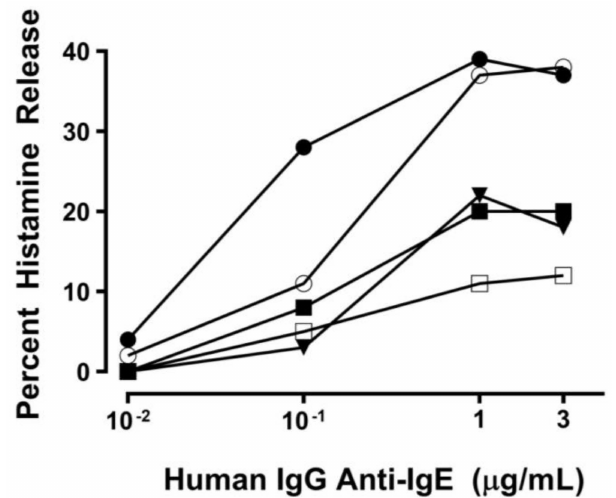
Figure 1. E ff ect of increasing concentrations of human IgG anti-IgE purified from the serum of a patient with atopic dermatitis [86] on histamine release from five di ff erent preparations of human heart mast cells (HHMCs). HHMCs were incubated (45 min at 37 ◦ C) with the indicated concentrations of human IgG anti-IgE. Each point shows the mean of duplicate determinations. Each symbol represents the results from an individual